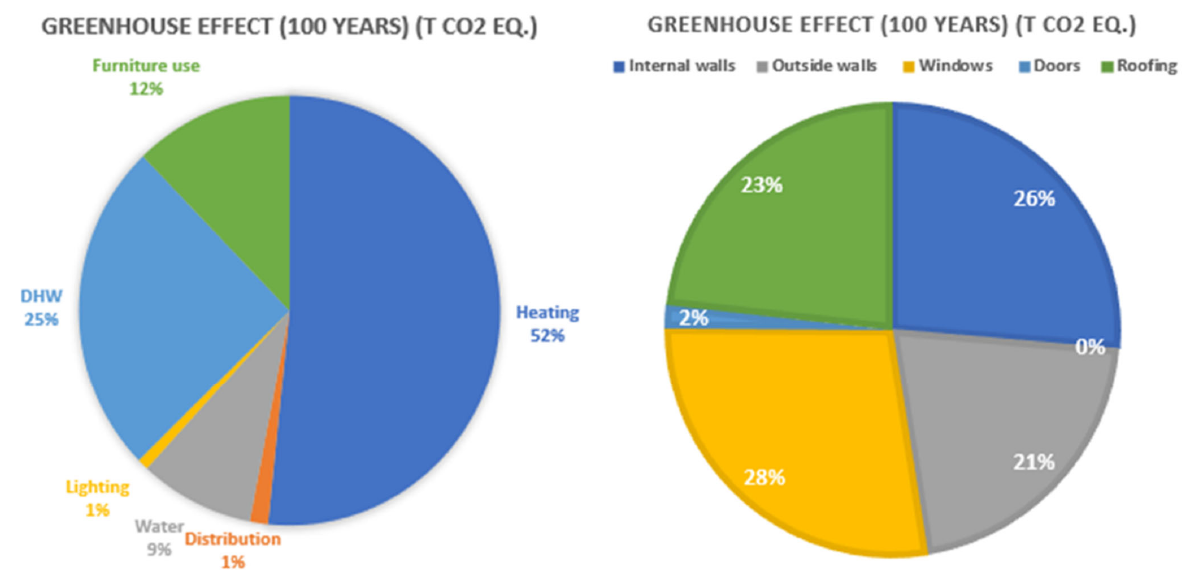
Figure 14. Greenhouse effect for the use and retrofit phases.